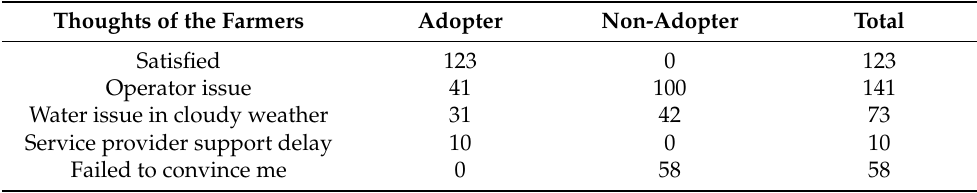
Table 6. Sentiment of the farmers towards service of the providers. Thoughts of the Farmers Adopter Non-Adopter Satisfied Water issue in cloudy